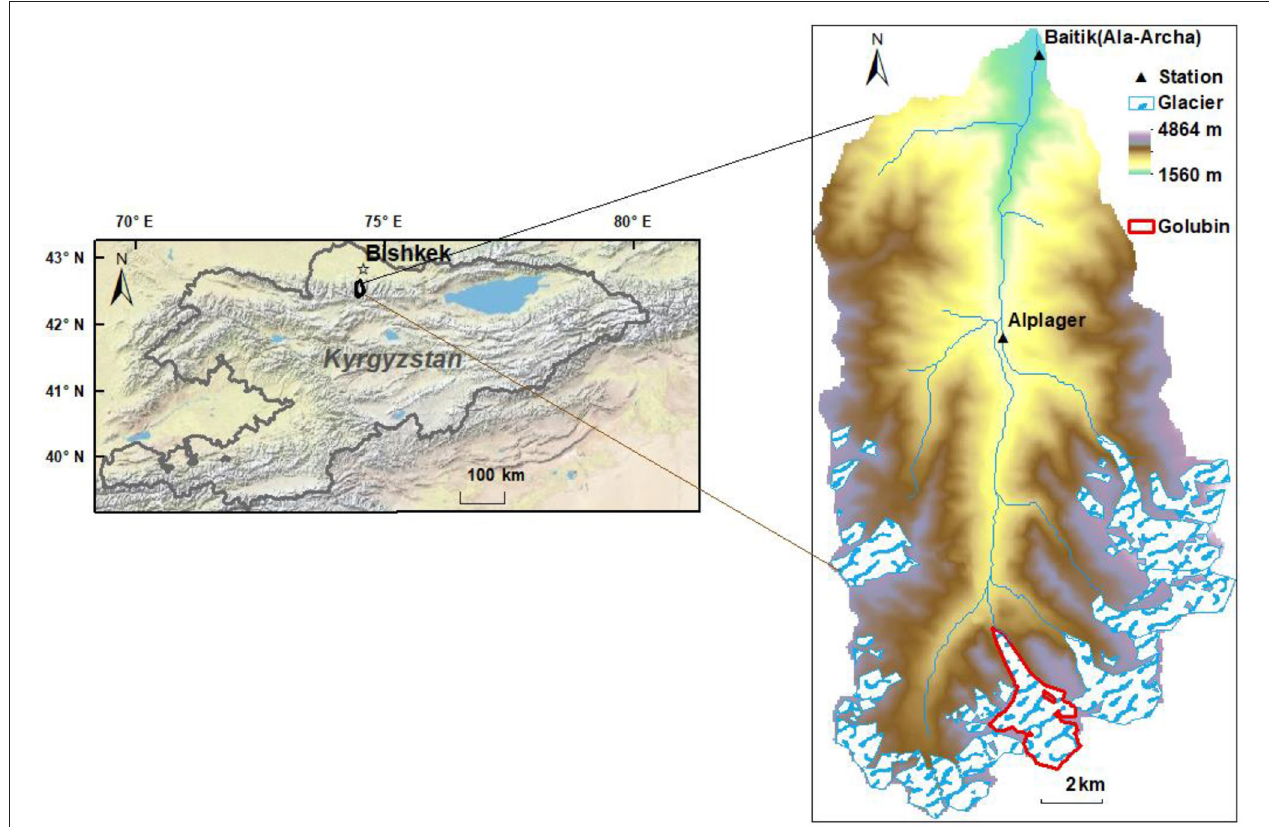
FIGURE 1 | Location of the Ala-Archa glacierized basin in Kyrgyzstan (derived from the World Topographic Map by © ESR, similarly to He et al., 2018, 2019, 2020).